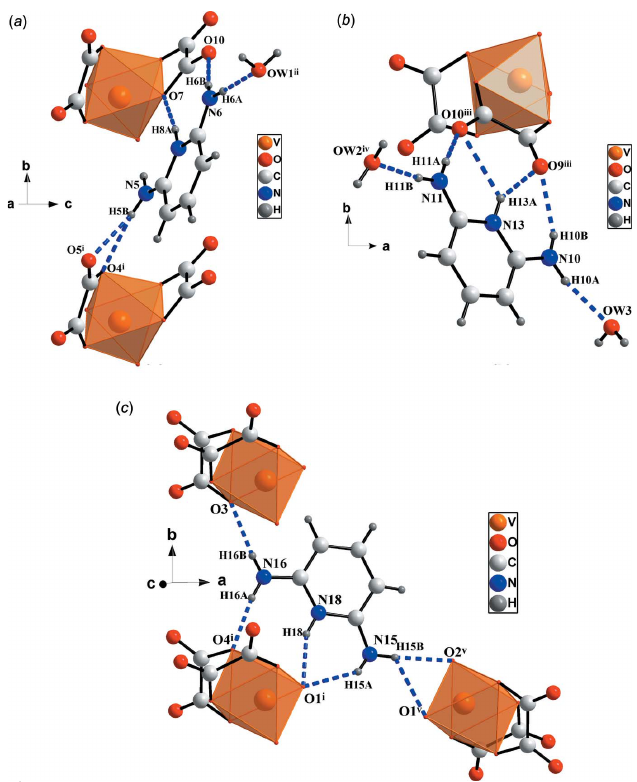
Figure 2 View of N—H (cid:2)(cid:2)(cid:2) O hydrogen bonds (blue dashed line) formed by ( a ) the first, ( b ) the second and ( c ) the third 2,6-diaminopyridinium cation. [Symmetry codes: (i) x , y (cid:3) 1, z ; (ii) (cid:3) x + 1 z (cid:3) 1 ; (iv) x , y + 1, z ; (v) (cid:3) x + 1, (cid:3) y , (cid:3) z + 1] 2